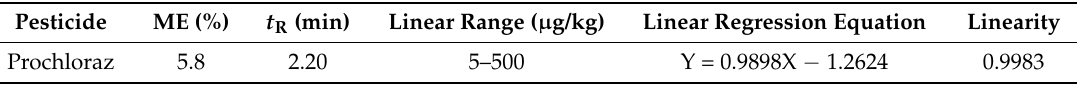
Table 2. Matrix effects (ME), retention time ( t R ), linear range, linear regression equation, and linearity.